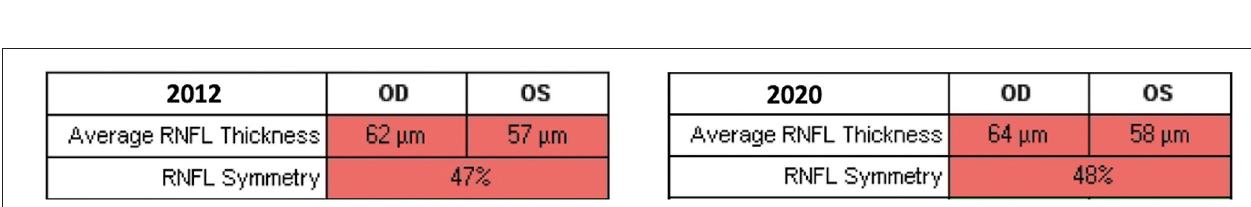
FIGURE 2 | Retinal nerve fiber layer (RNFL) thickness evaluated with spectral domain-optical coherence tomography. Average RNFL thickness and RNFL symmetry did not change significantly throughout the follow-up period.